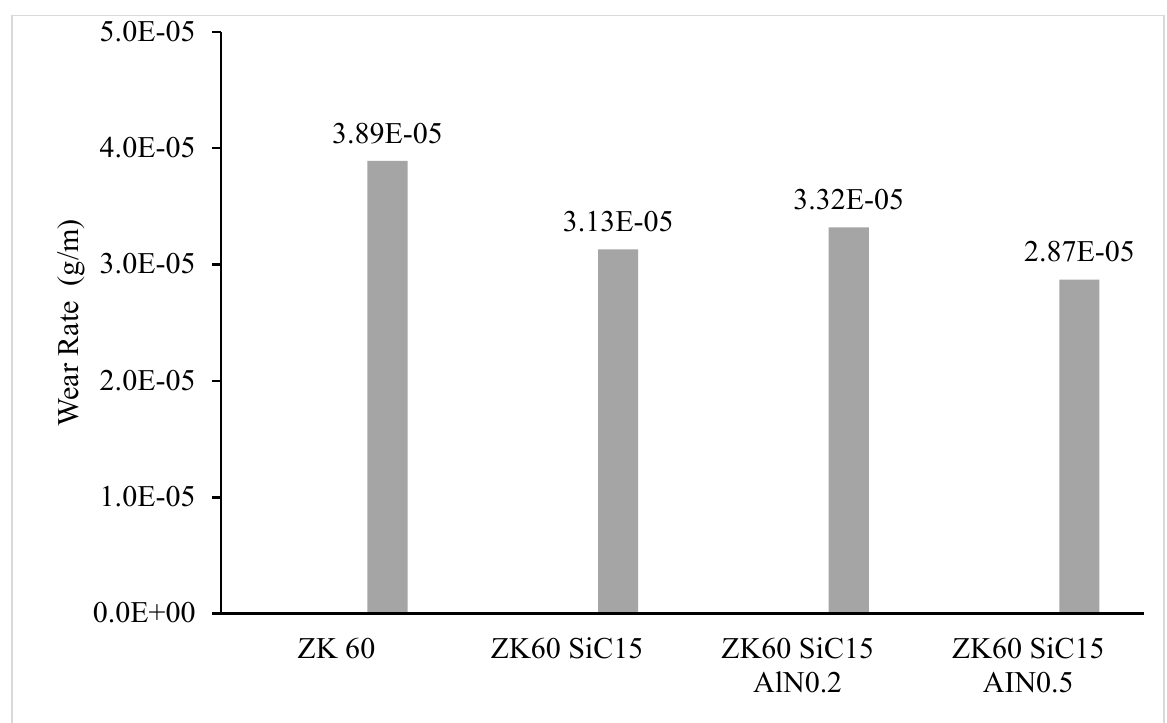
Figure 13. The calculated wear rates of all composites (g/m).